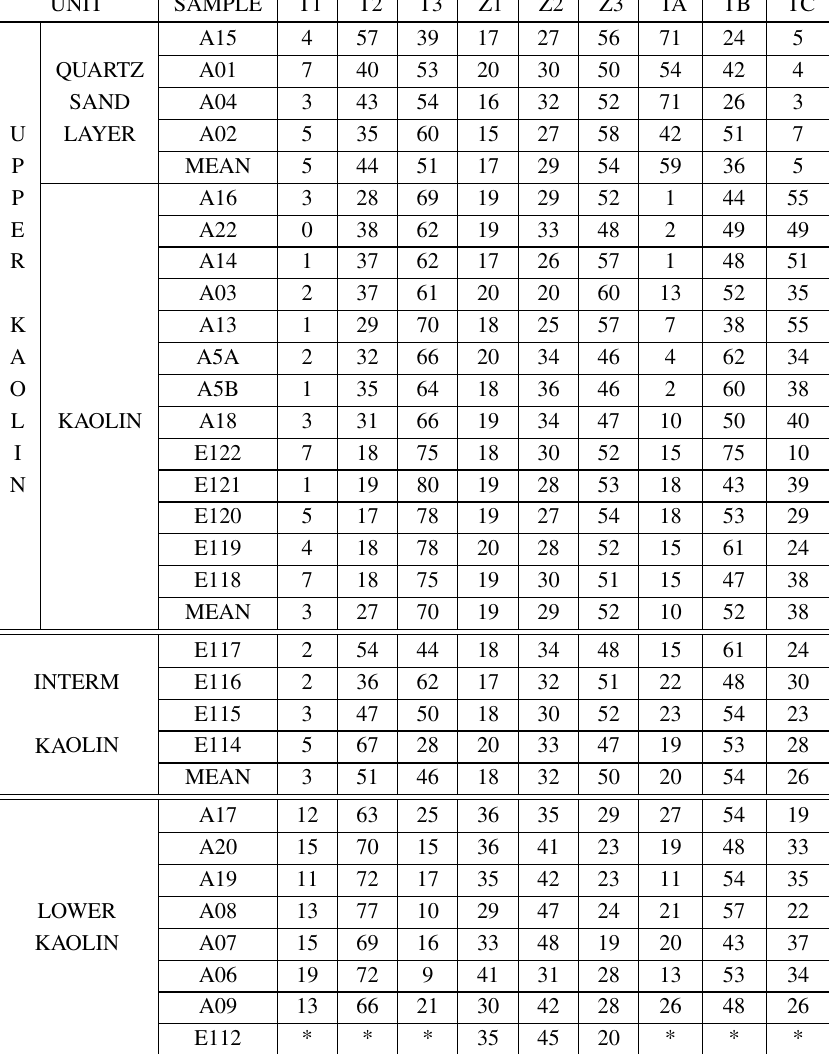
Morphologies and alteration of tourmaline and morphologies of zircon grains from kaolin units in IRCC quarry. * = insufficient grains, T1 = euhedric to sub-euhedric tourmaline, T2 = anhedric angular to sub-angular tourmaline, T3 = anhedric rounded to sub-rounded tourmaline, Z1 = euhedric to sub-euhedric zircon, Z2 = anhedric an- gular to sub-angular zircon, Z3 = anhedric rounded to sub-rounded zircon, TA = unaltered tourmaline, TB = altered tourmaline and TC = very altered tourmaline.